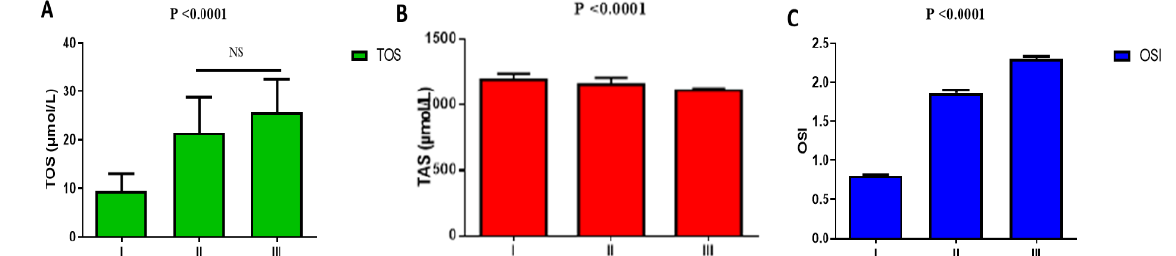
Figure 2. Metformin effects on oxidative stress in T2DM patients with COVID-19: I: T2DM patients on metformin, II: T2DM with mild-moderate COVID-19 on metformin, III: T2DM patients with severe COVID-19 on metformin. ( A ): TOS: total oxidant status; ( B ): TAS: total antioxidant status; ( C ): OSI: oxidative stress index. NS: not